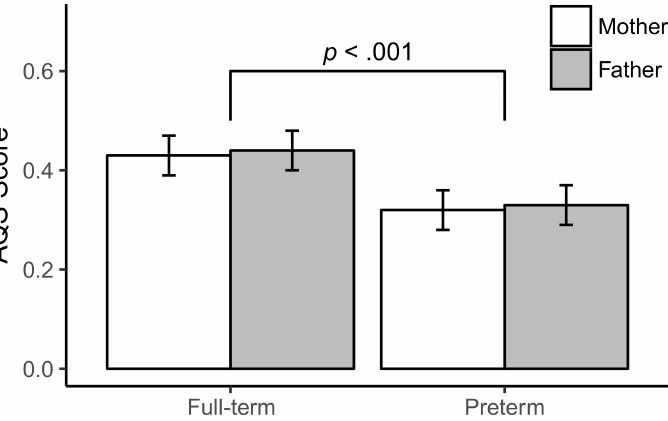
Fig 1. AQS-score group means of mothers and fathers of children born full-term or preterm.